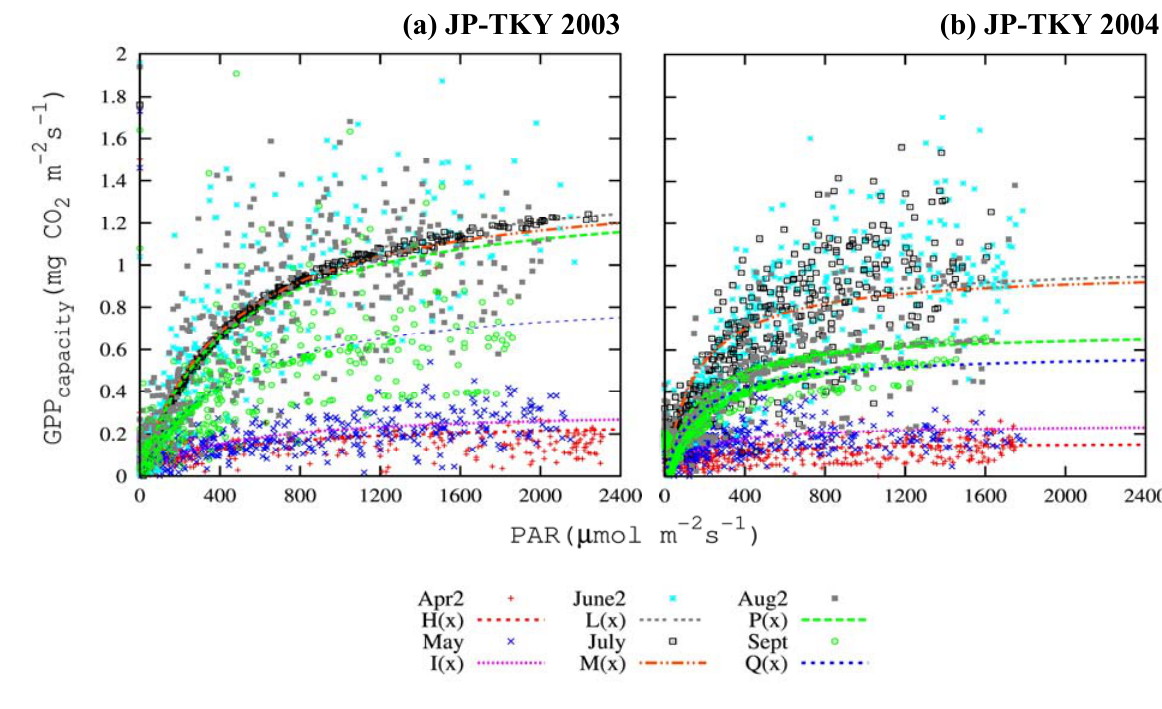
Figure 6. Light-response curve of low-stress GPP (GPP deciduous temperate trees (JP-TKY) in ( a ) 2003 and ( b ) 2004. Lines represent the least-squares fitting curve for each 16-day period. Dots in different colors indicate half-hourly data (no average) of each 16-day period of GPP